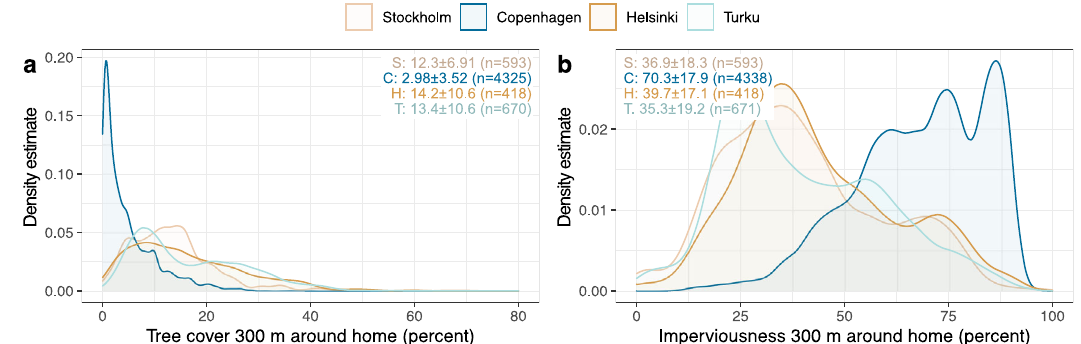
Fig. 5 Tree cover density (TCD) and imperviousness density (ID) within 300m around the respondent ’ s place of residence. x -axes show a percent tree cover and b percent imperviousness surface around the respondent ’ s place of residence at 300 m distance, while y -axis show data point density estimates. The data are grouped by city, with median ± MAD and number of outdoor recreation sites for each city in the upper